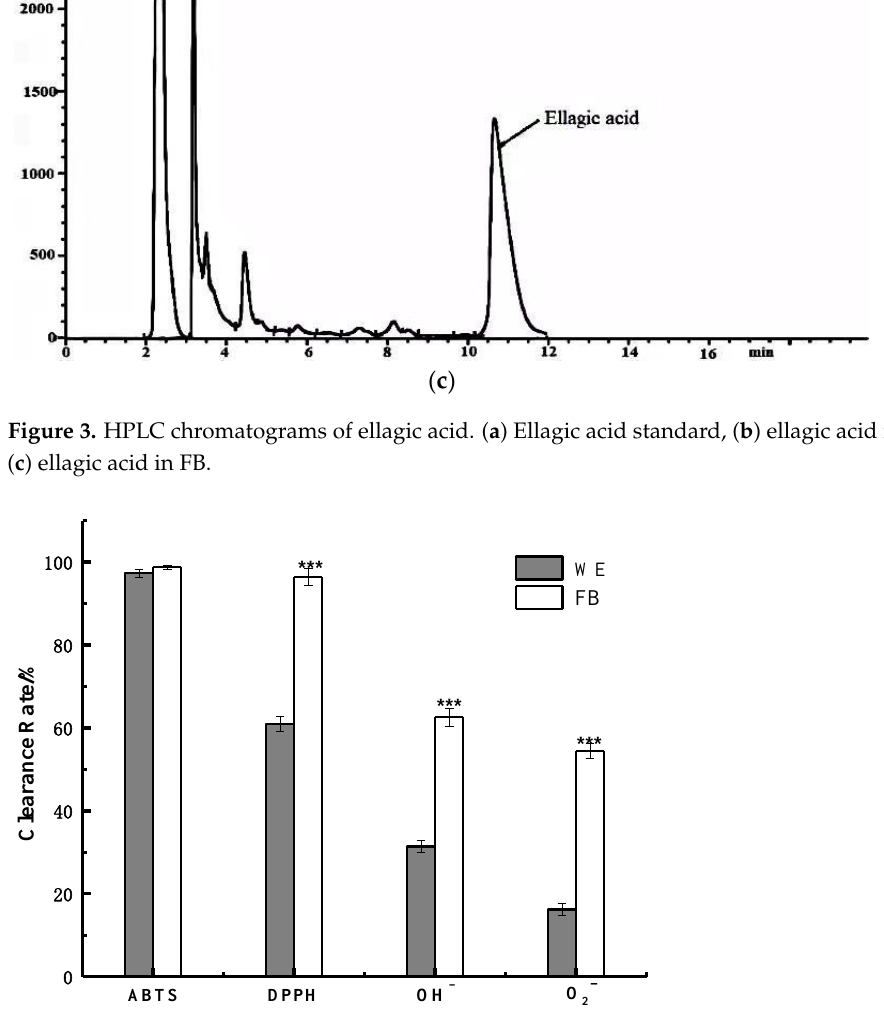
Figure 4. Antioxidant ability of the WE and FB. Significance: *** p < 0.001 vs. WE-treated group. Data shown as the mean ± S.D. ( n = 3).